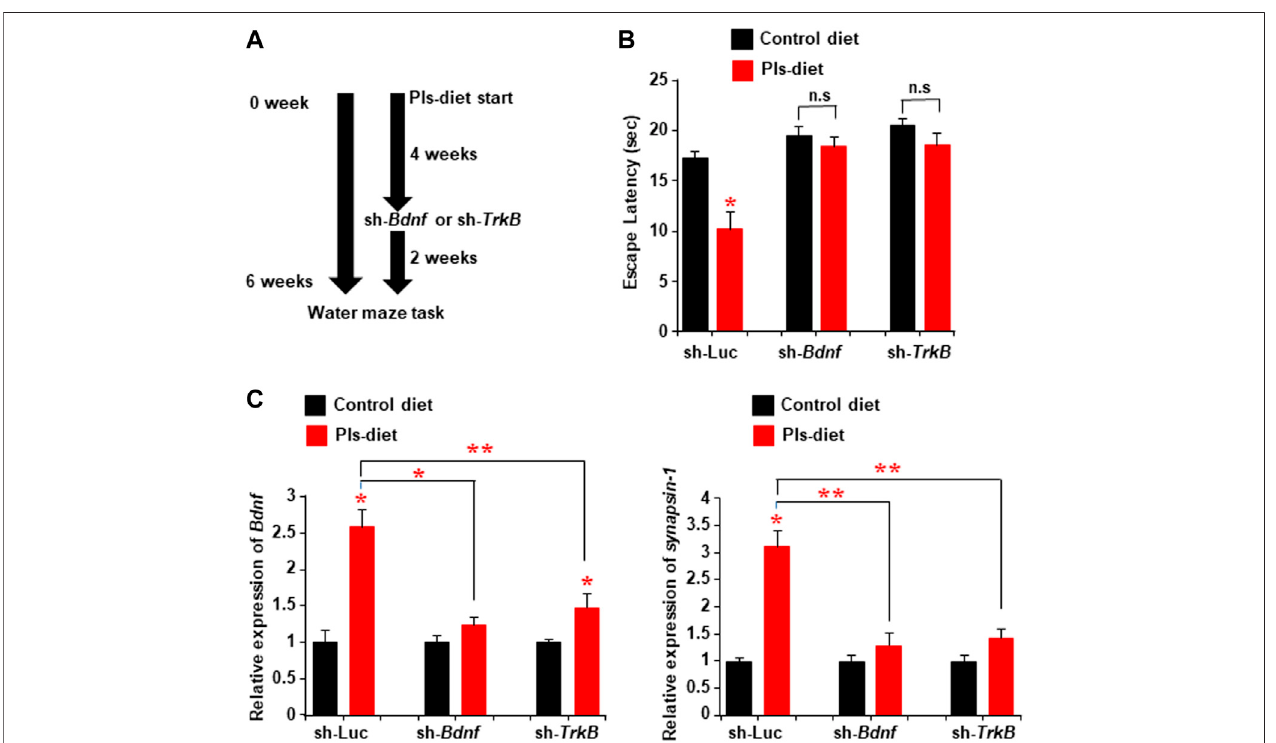
FIGURE 8 | Attenuation of Pls-mediated memory enhancement by knockdown of hippocampal TrkB or Bdnf expression. (A) Mice were subjected to the Pls feeding for 4 weeks followed by the sh- Bdnf or sh- TrkB injection bilaterally into the hippocampus. The water maze task was performed 6 weeks after Pls feeding. (B) Water maze data show the difference in escape latency between the experimental group mice. The data represent the mean values of the swimming time to reach the goalonthefourth-daytrails(3trailsperday). (C) Real-timePCRdatashowtheexpressionof Bdnf and synapsin-1 inthehippocampustissuesofthemice.Thedata represent the mean ± S.E.M. Each experiment included more than fi ve mice. *, p < 0.05 and **, p < 0.01 (ANOVA followed by Bonferroni ’ s post hoc tests).